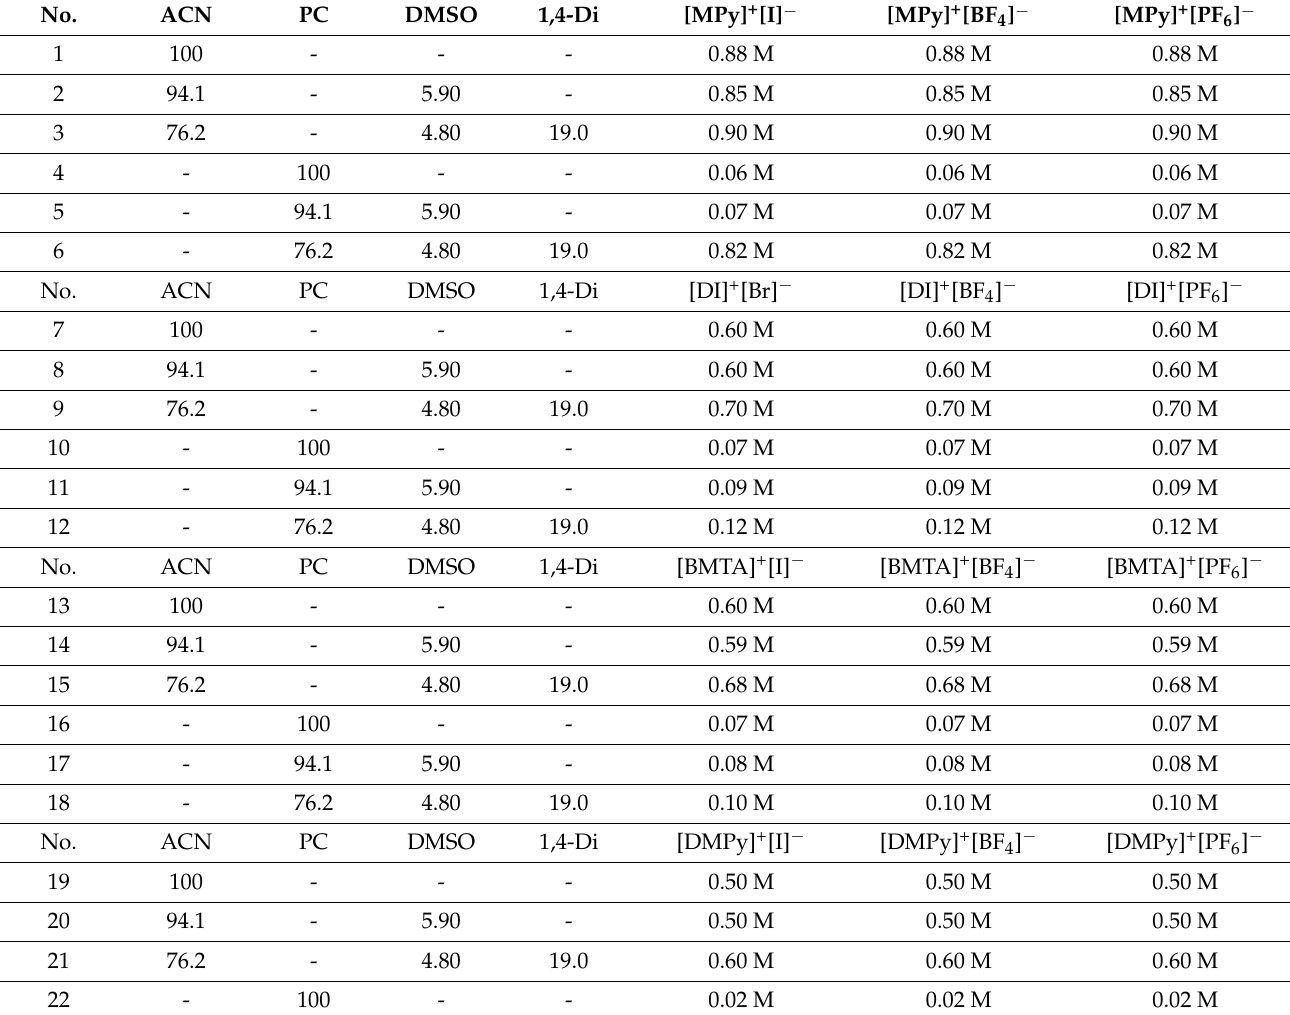
Table 1. Solubility of the V(acac) 3 in polar organic solution in the presence of N-heterocyclic aromatic salts (a) .